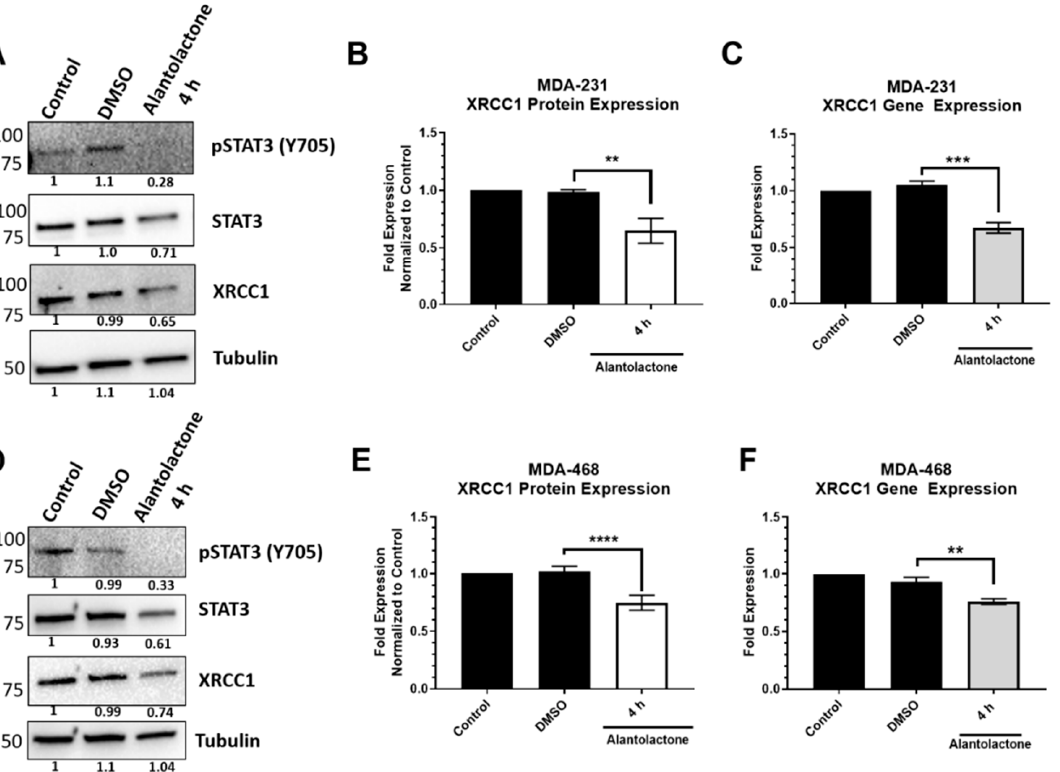
Figure 5. Chemical inhibition of the phosphorylation of STAT3 at Y705 by alantolactone decreases the expression of XRCC1 in MDA-231 and MDA-468 cells. ( A ) Representative immunoblots of phospho-STAT3 (Y705), STAT3 and XRCC1 protein expression after 4 h of exposure to 15 µ M alantolactone in MDA-231 cells. α -tubulin is used as a loading control. ( B ) Quantification of protein expression changes in XRCC1 resulting from 4 h of alantolactone exposure in MDA-231 cells. ( C ) Quantification of XRCC1 mRNA expression following 4 h of alantolactone exposure in MDA-231 cells. ( D ) Representative immunoblots of phospho-STAT3 (Y705), STAT3 and XRCC1 protein expression after 4 h of exposure to 15 µ M alantolactone in MDA-468 cells. ( E ) Quantification of protein expression changes in XRCC1 resulting from 4 h of alantolactone exposure in MDA-468 cells. ( F ) Quantification of XRCC1 mRNA expression following 4 h of alantolactone exposure in MDA-468 cells. ** p < 0.01, *** p < 0.001, **** p <